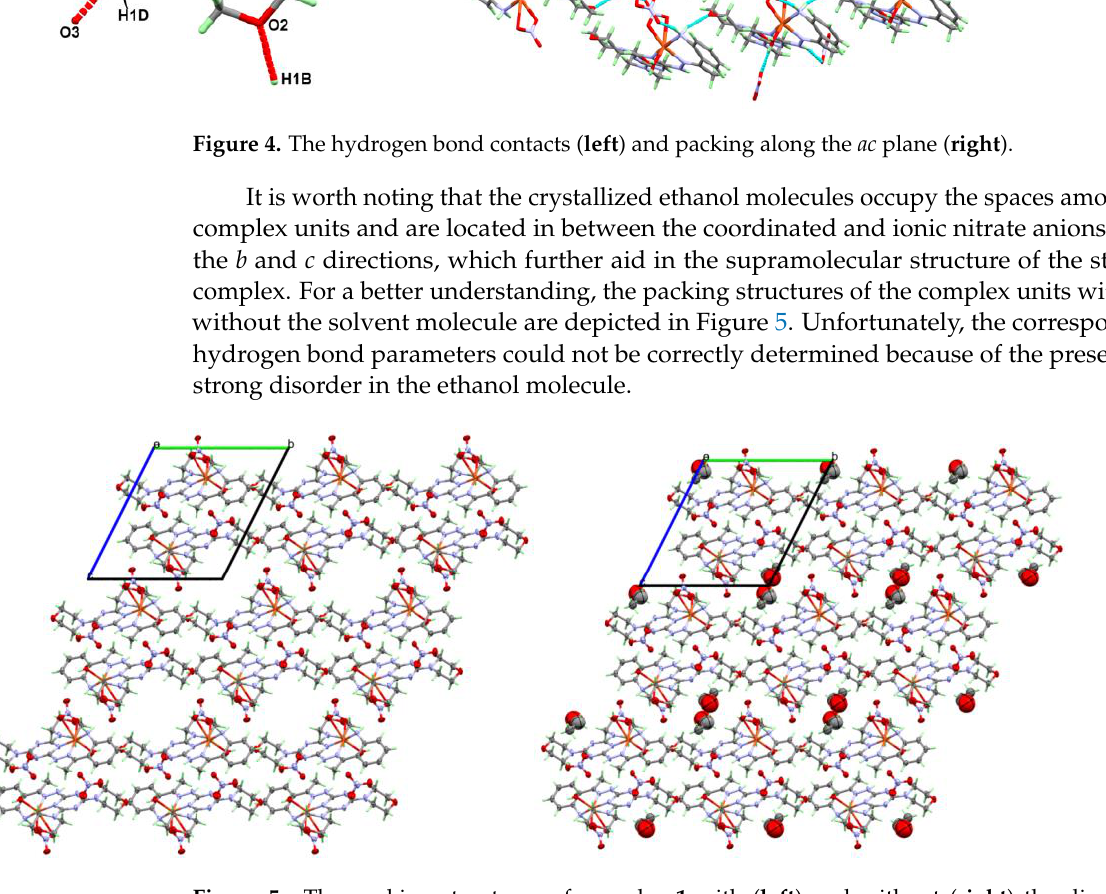
Figure 5. The packing structures of complex 1 with ( left ) and without ( right ) the disordered etha- nol molecule.